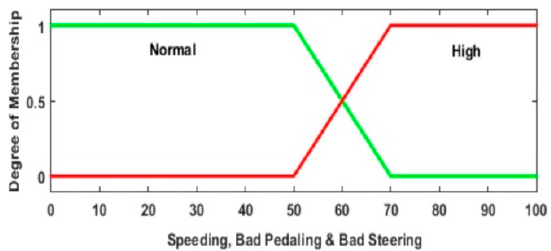
Figure 5. Proposed output variables membership functions: Speeding , Bad Pedaling and Bad Steering .